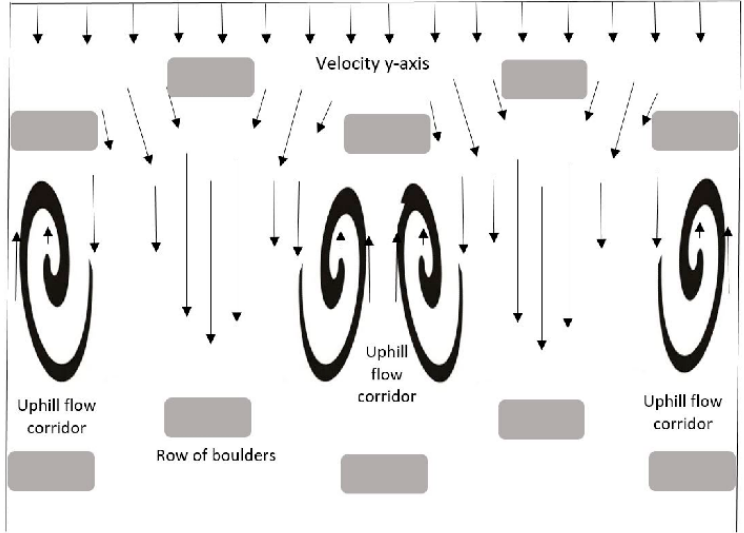
Figure 1. Illustration of resulting uphill flows due to zig-zag boulder distribution.